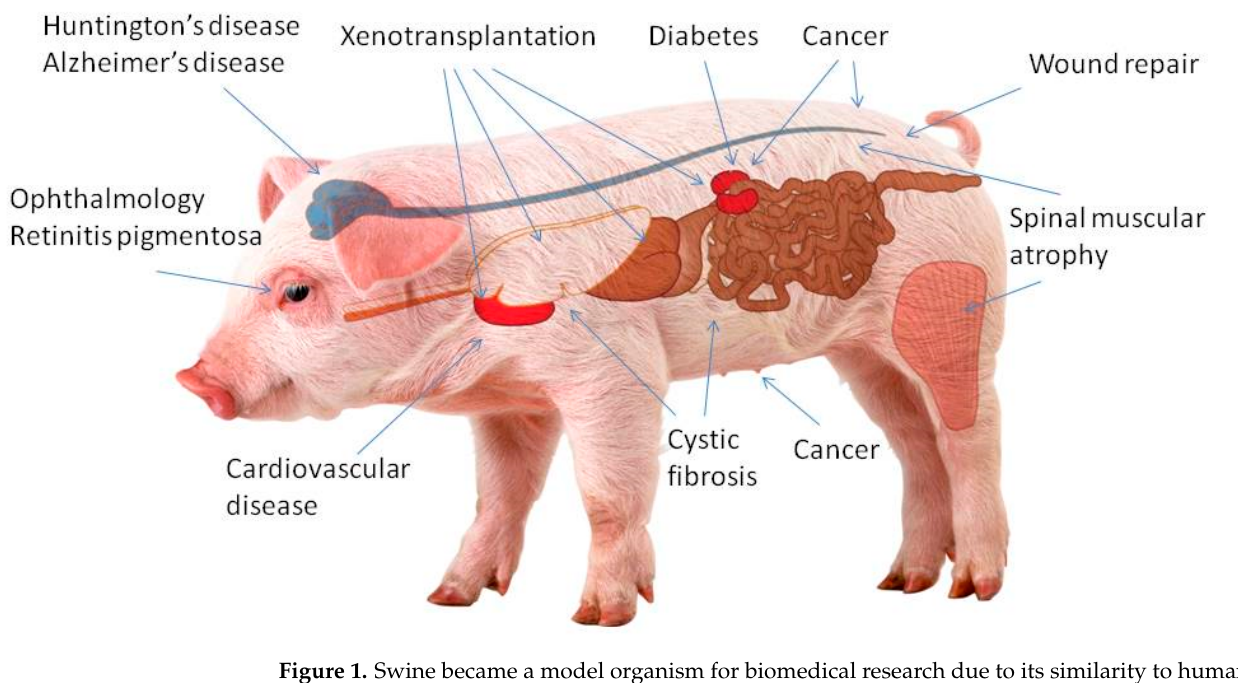
Figure 1. Swine became a model organism for biomedical research due to its similarity to humans. Pigs are ideal organisms for studying human health and disease. Their genome is three times closer than the mouse genome to that of humans.